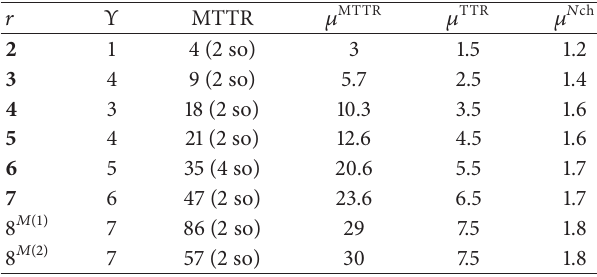
(3, 15) , (4, 28) , (5,45) , (6,66) , (7,91) , (8,120)} .